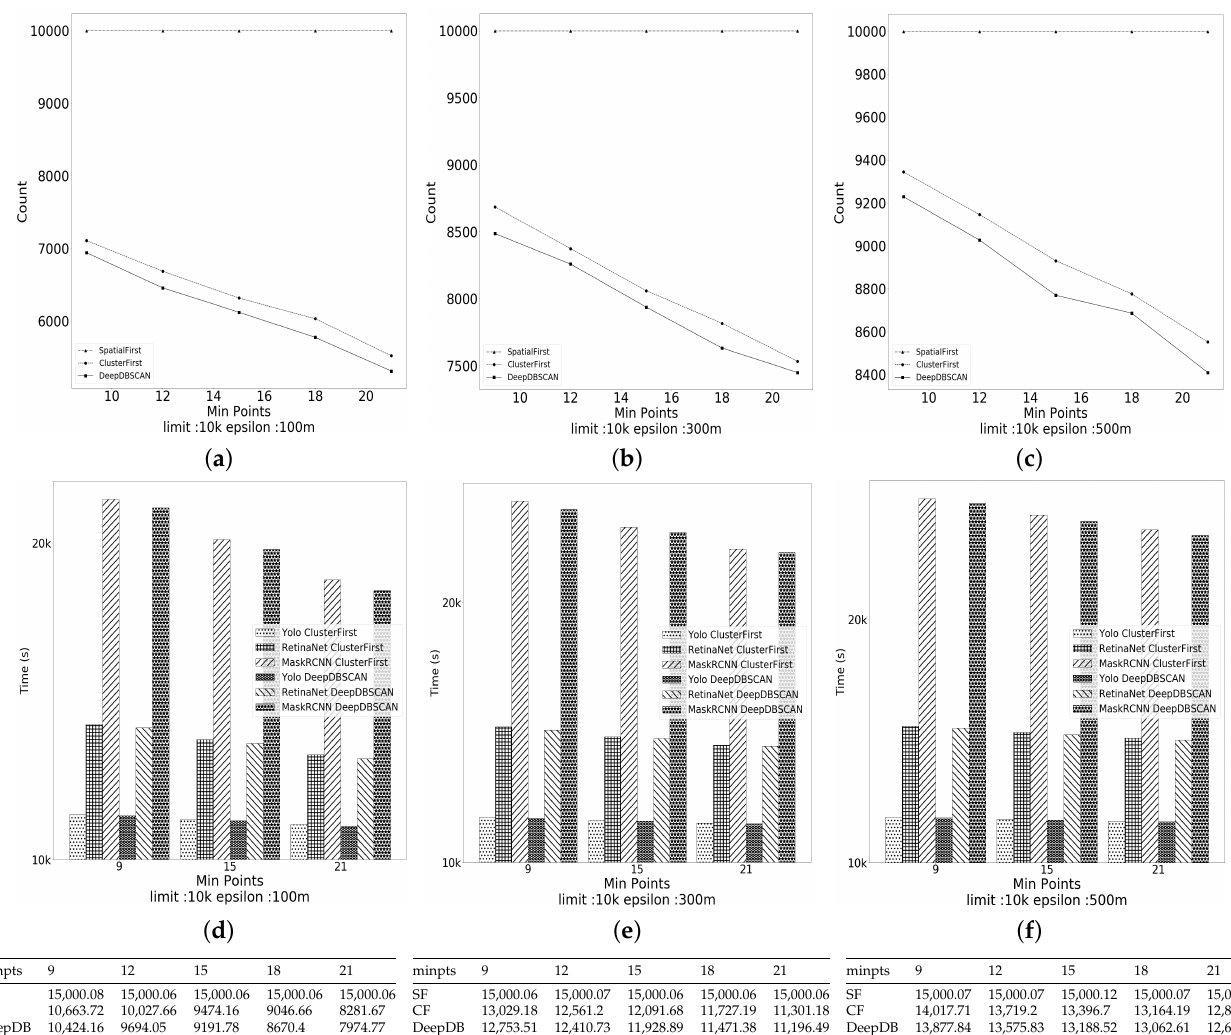
Figure 9. Effect of the minimum number of points. ( a – c ) number of object detections when epsilon 100 m to 500 m; ( d – f ) The time cost of each object detection model when epsilon 100 m to 500